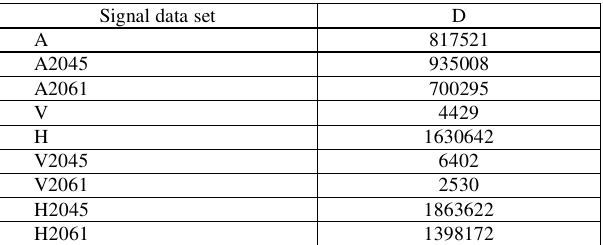
Table 2. The distances between the data sets for engine working before and after a repair Signal data set